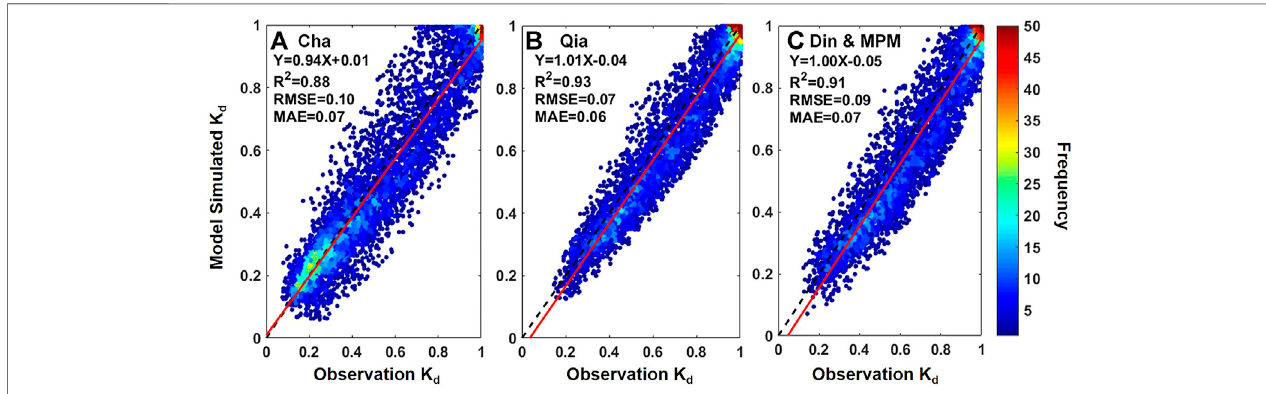
FIGURE 3 | Density scatterplots of the model-simulated K d . (A – C) are Cha, Qia, Din and MPM sites; the dashed black and solid red lines indicate the 1:1 line and the linear regression line, respectively.